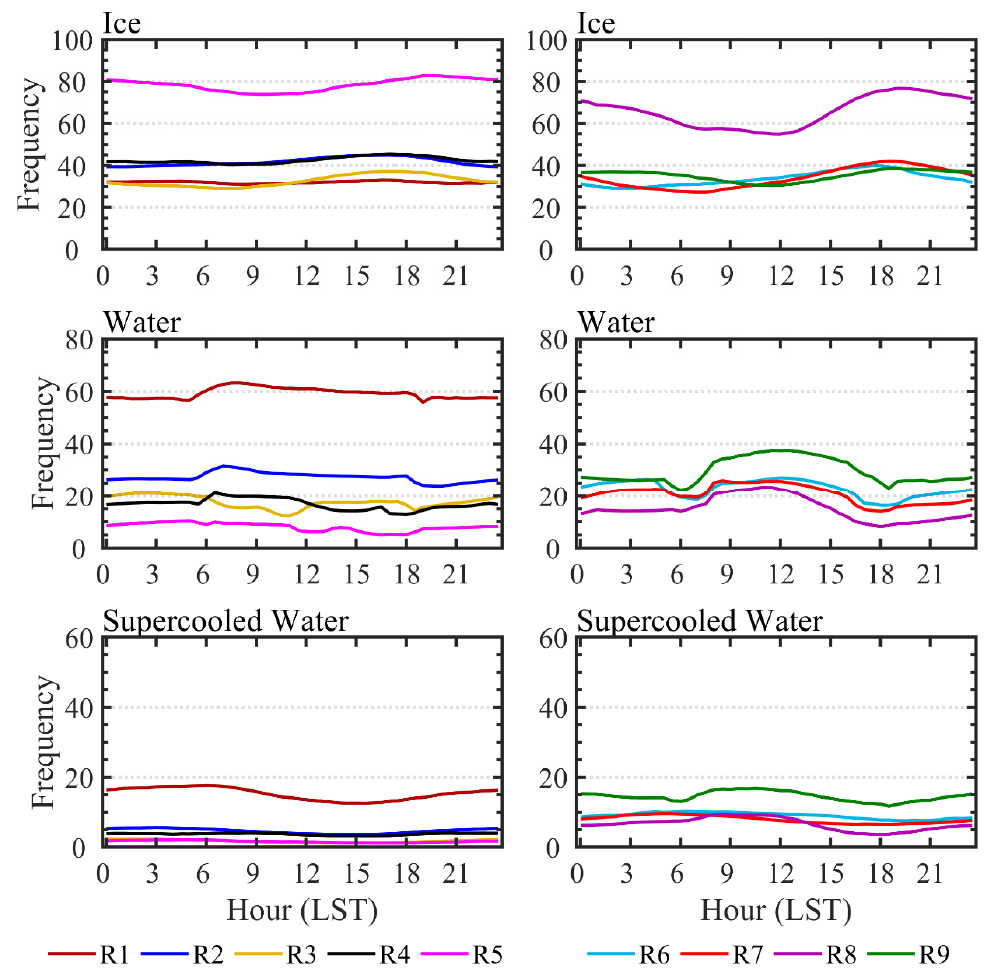
Figure 11. Diurnal variations in the frequencies (unit: %) of different cloud-top phases over five maritime regions (left panels) and four continental regions (right panels) in the 3-year boreal summer.